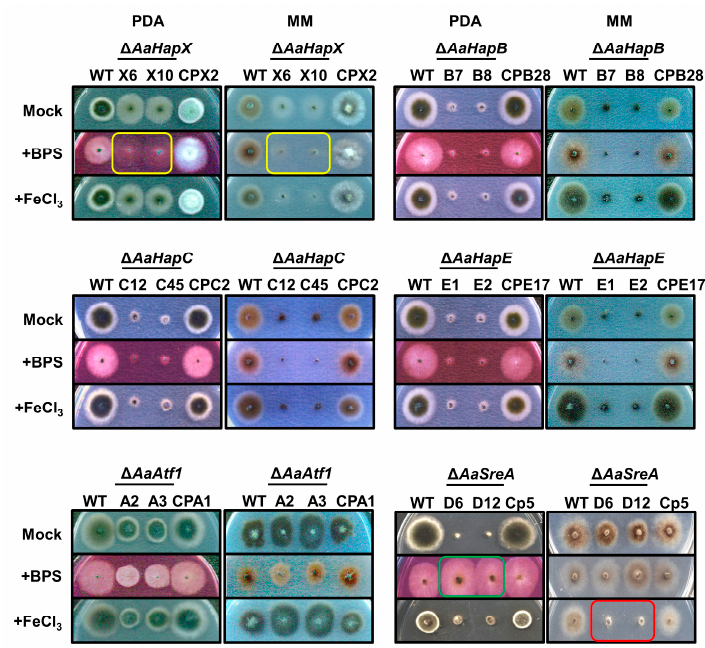
Figure 2. Transcription regulators involved in iron homeostasis and growth in A. alternata under iron-replete (PDA) and iron-depleted (MM) conditions. Fungal strains, including wild type (WT), deletion mutants ( ∆ ), and complementation strains (CP) were transferred by pipette tips to PDA and MM amended with or without 0.2 mM FeCl3 or 0.2 mM bathophenanthrolinedisulfonic acid (BPS) and incubated at 28 °C for 3 to 5 days. ∆ AaHapX grew poorly on a medium amended with BPS (indicated by yellow rectangles). However, ∆ AaSreA grew poorly under iron-rich conditions (indicated by a red rectangle), and exhibited wild-type growth in the presence of BPS (indicated by a green rectangle). ∆ AaHapB , ∆ AaHapC , and ∆ AaHapE grew poorly on either medium. Experiments were tested at least two times with two replicates for each treatment.